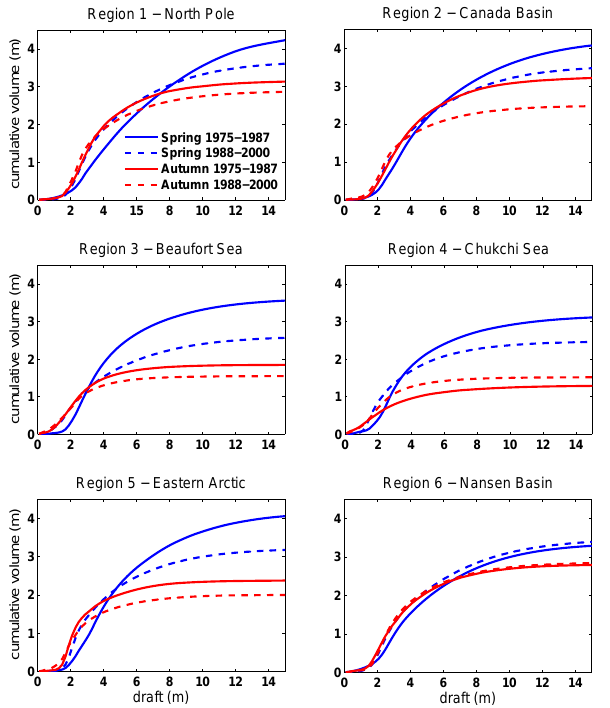
Fig. 5. Regional cumulative ice volume distribution in Spring and Autumn during the periods 1975–1987 and 1988–2000. Bin width 0.2m. Integration of ice volume distribution results in mean ice draft, which corresponds to ice volume over unit